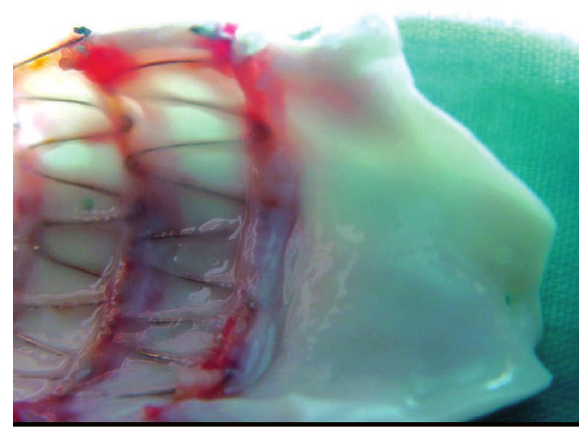
Fig. 4 - Corte longitudinal da aorta, no qual visibilizamos a transição entre a parede aórtica normal e a região espessada pelas reações induzidas pelo stent.